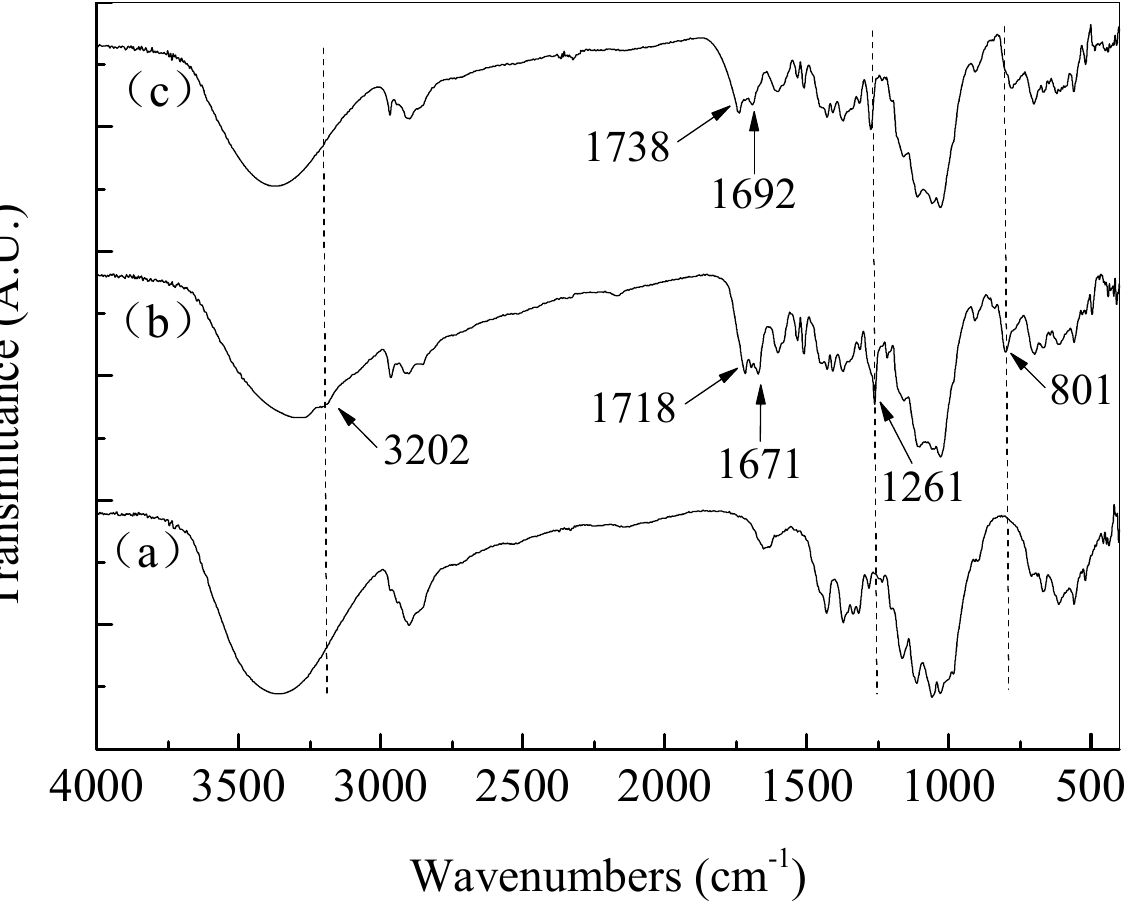
Figure 3. FTIR spectra of pristine cellulose ( a ), barbituric acid-based polysiloxane@cellulose ( b ), and cyclic imide N -halamine polysiloxane@cellulose ( c ).